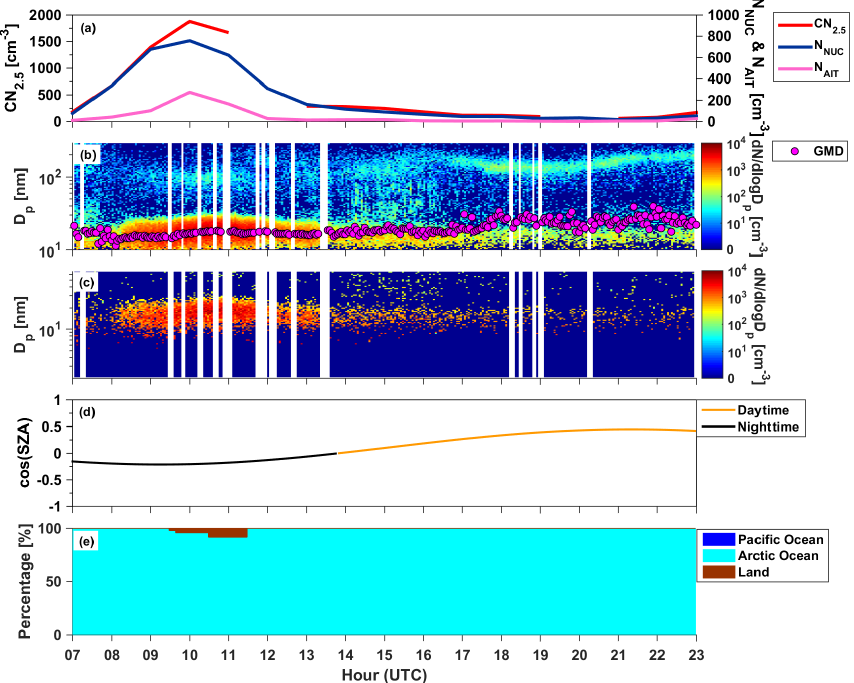
Figure 4. Example of a case I event observed on 3 September 2017. From top to bottom, the parameters are as follows: (a) the total number concentration of particles smaller than 2.5nm, nucleation-mode particles and Aitken-mode particles; (b) a time series of the standard-SMPS size distribution and GMD; (c) a time series of the nano-SMPS size; (d) cosine values of solar zenith angle; and (e) the residence time of air masses that passed over the ocean, land and sea-ice